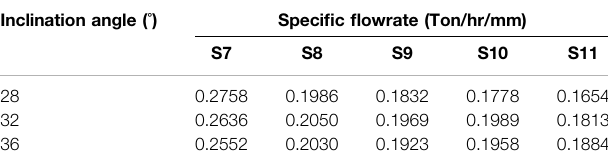
TABLE 5 | Hopper-speci fi c fl owrate through the wedge hopper per unit hopper